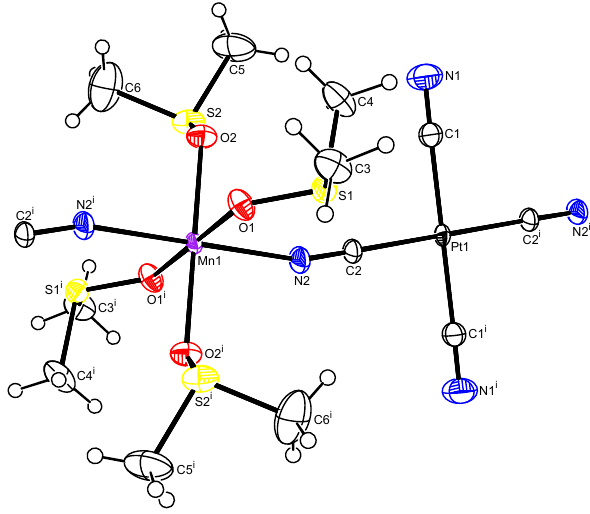
Table  : Data collection and